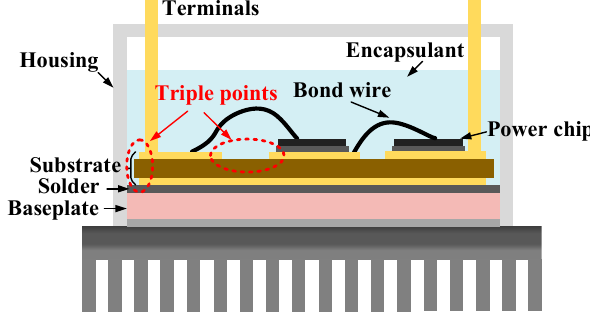
Figure 8. Schematic of a typical power electronic packaging.